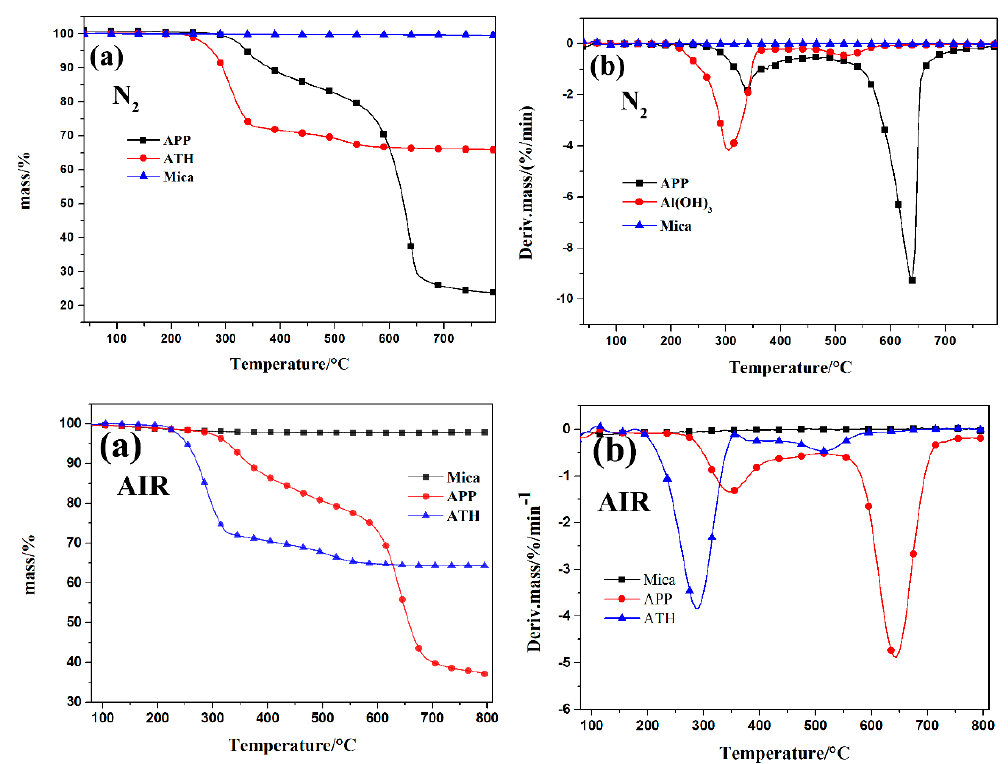
Figure 7. TG and DTG curves of Al(OH) 3 , APP, and mica under N 2 and air atmosphere.